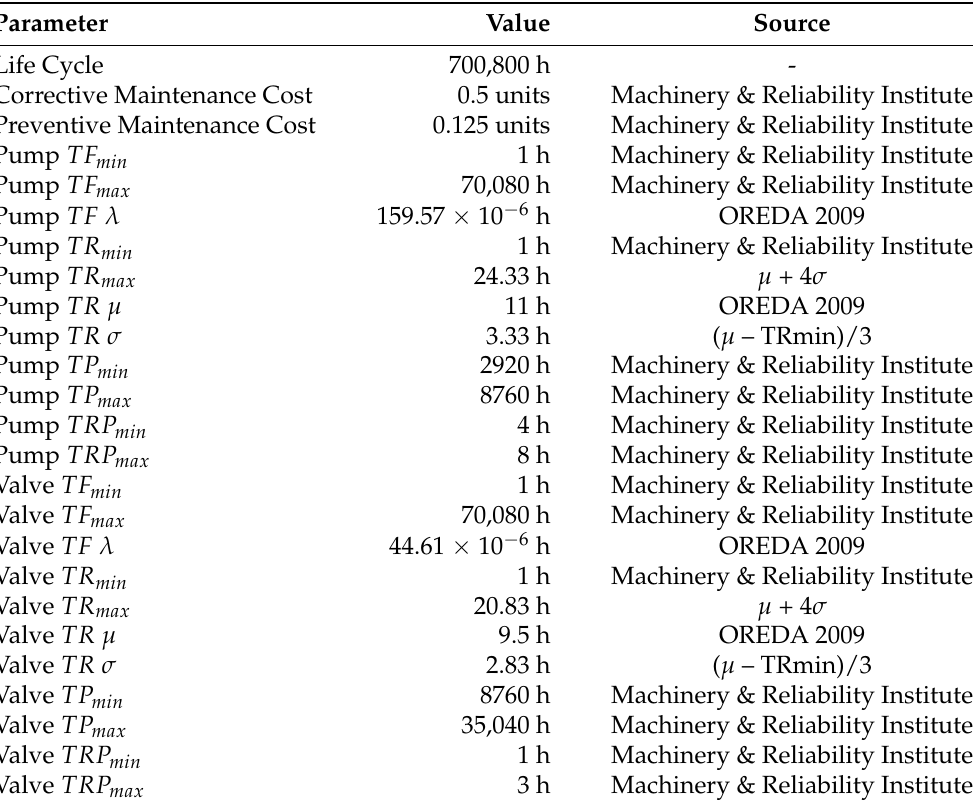
Table 1. Data set for system